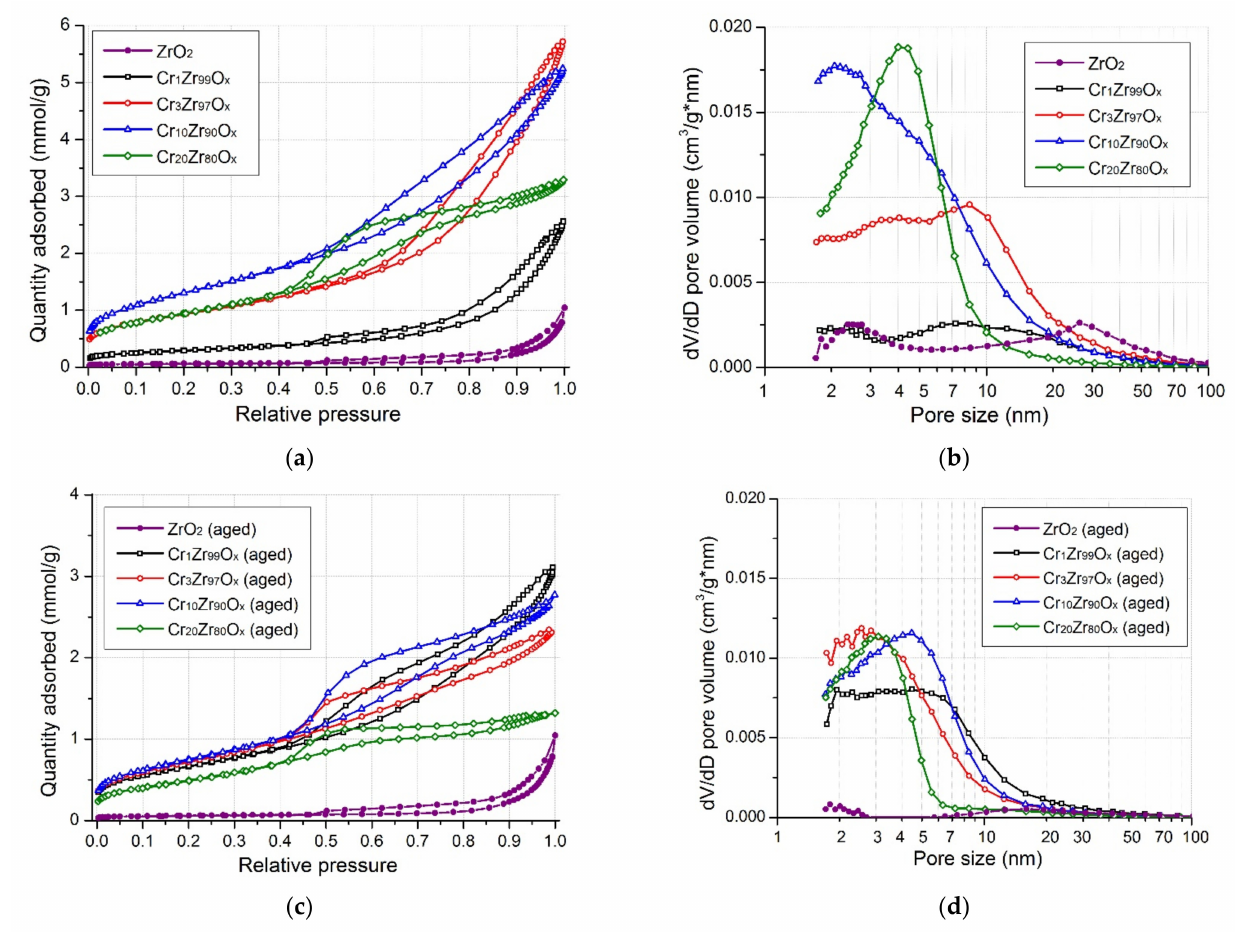
Figure 1. Nitrogen adsorption–desorption isotherms ( a , c ) and pore size distributions ( b , d ) for prepared catalysts: ( a , b ) without ageing, ( c , d ) with ageing of